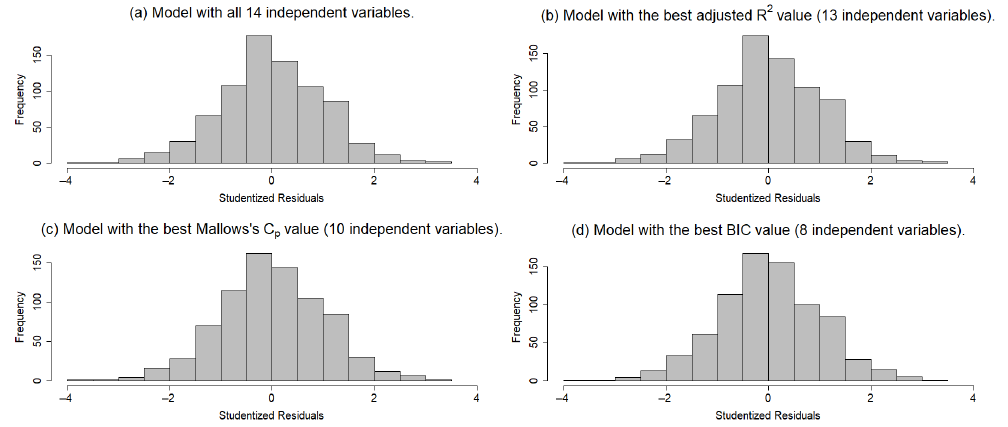
Figure 2. Histograms of Studentized residuals for four